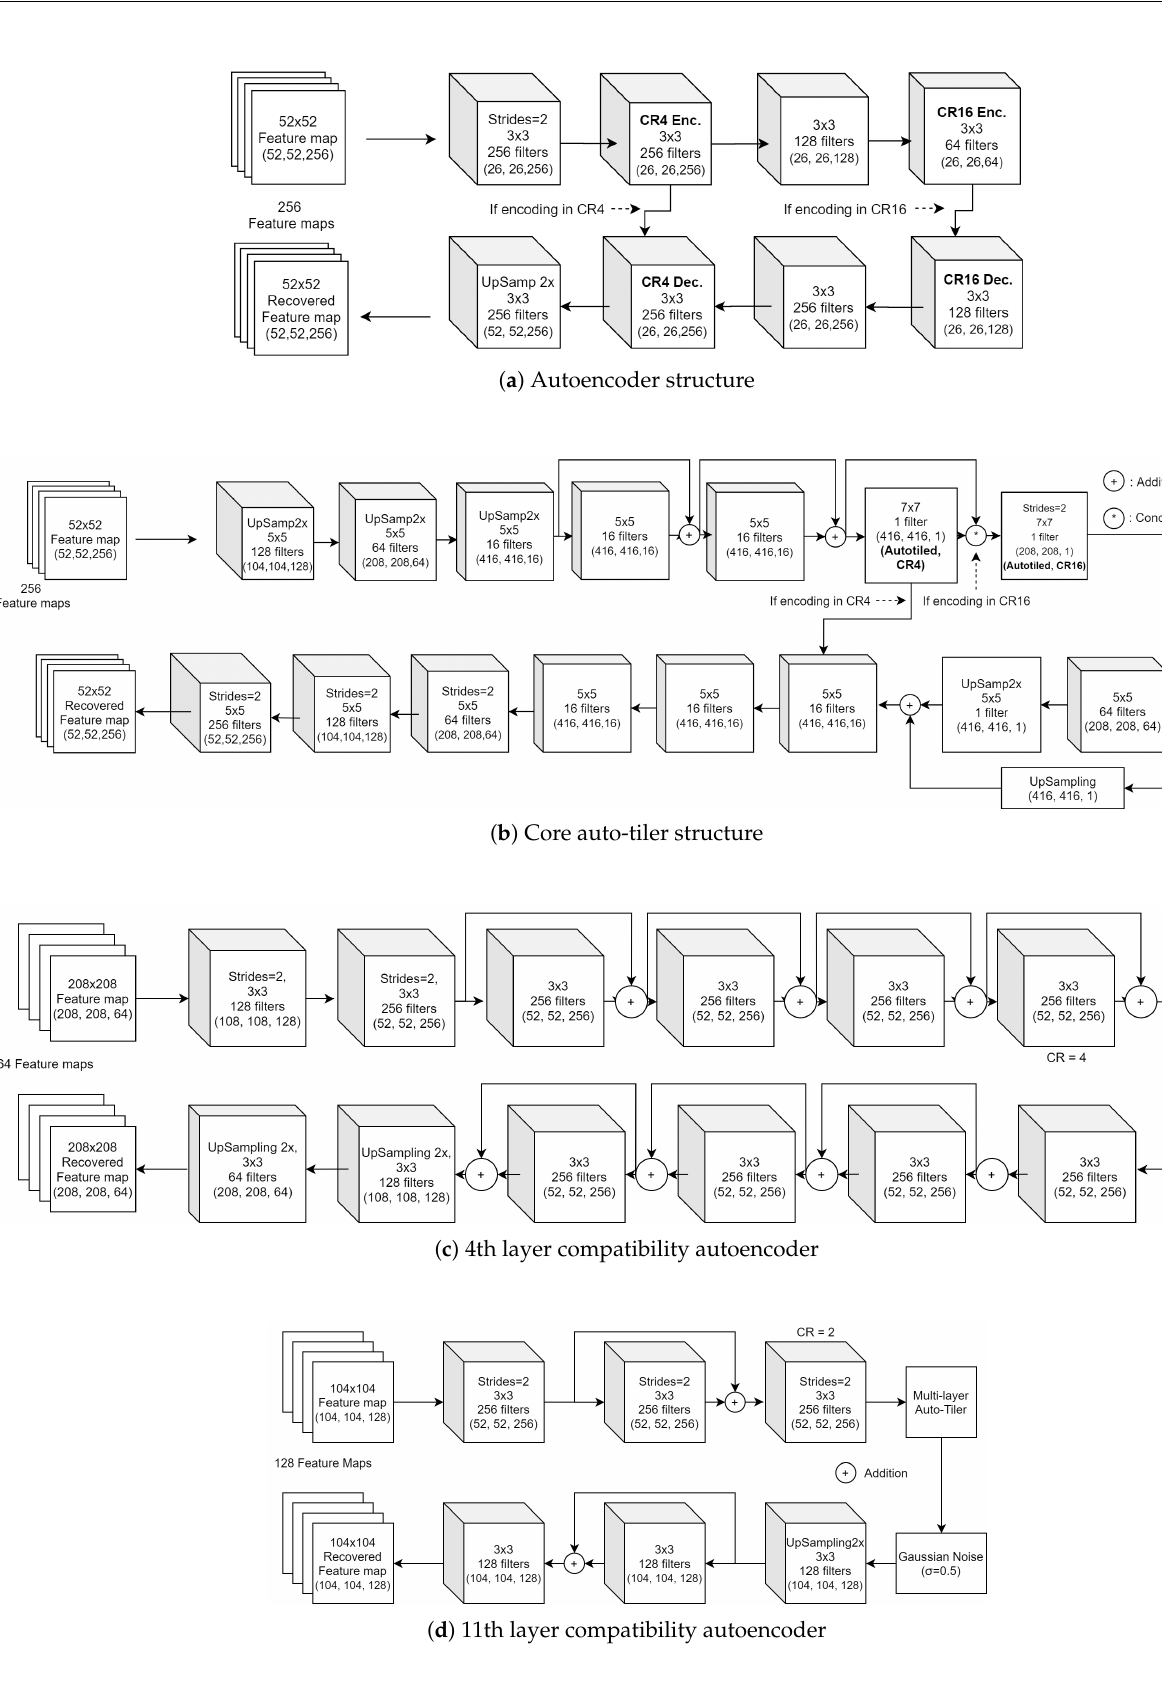
Figure 8. Network structure of ( a ) autoencoder, ( b ) multi-layer auto-tiler, ( c ) 4th layer compatibility autoencoder, and ( d ) 11th layer compatibility